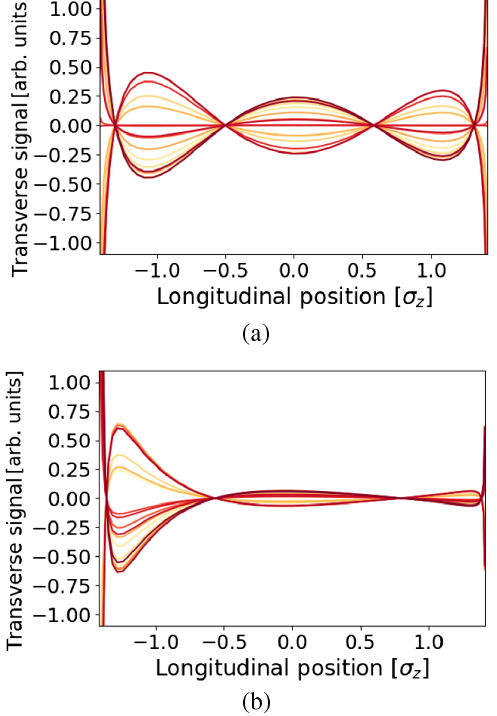
FIG. 6. Transverse signals obtained for the azimuthal mode 4 for different strengths of the space charge force and for an airbag distribution. The normalized intensity is 20, i.e., well beyond the TMCI threshold in the absence of space charge forces. The positive longitudinal positions correspond to the head of the bunch, i.e., the part of the beam that arrives first at a given location around the ring. (a) Δ Q